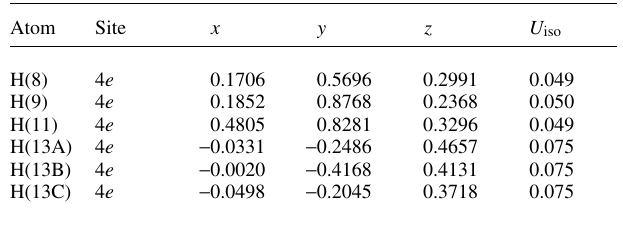
Table 2. Atomic coordinates and displacement parameters (in Å 2 )